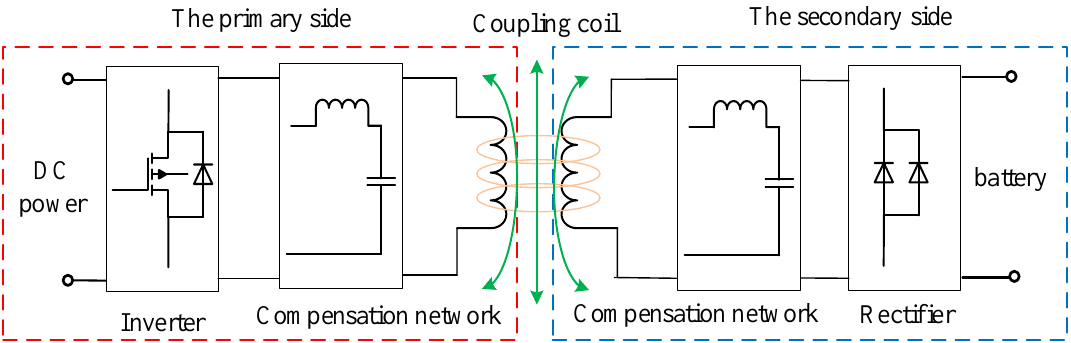
Figure 1. Principle and structure diagram of IPT system .